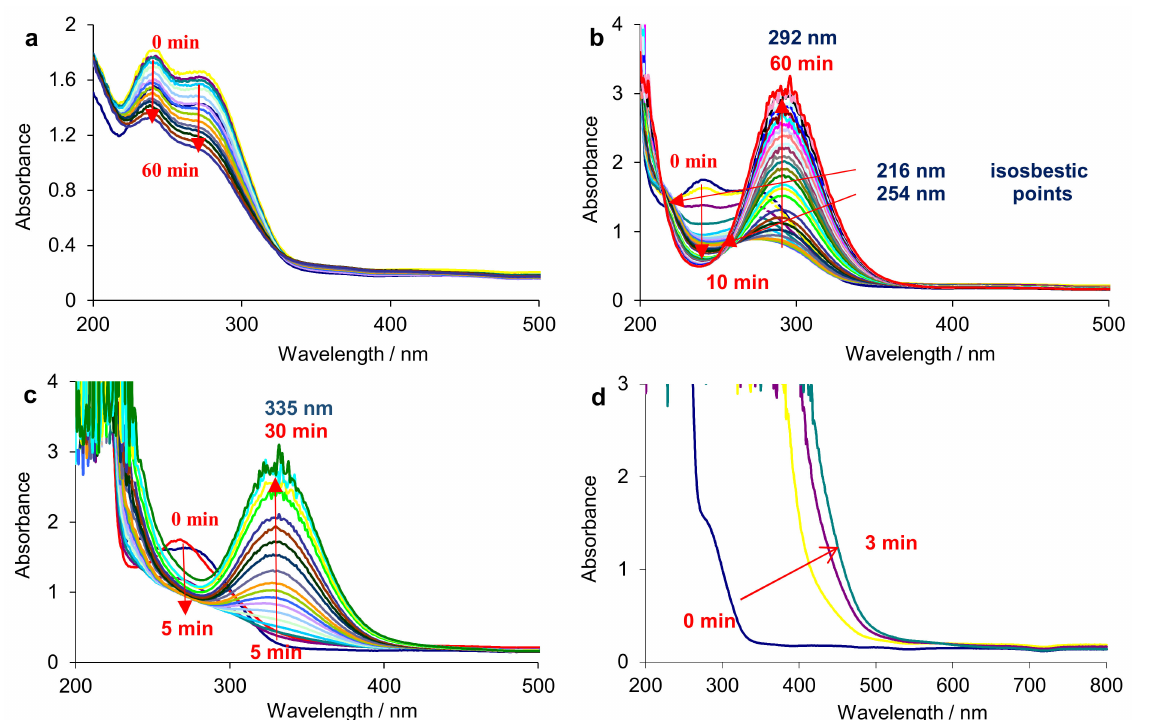
Figure 3. UV-Vis spectra of CFTX recorded on platinum electrode, in solutions of sodium halides during constant current electrolysis: ( a ) CFTX/NaF solution; ( b ) CFTX/NaCl solution; ( c ) CFTX/NaBr solution; ( d ) CFTX/NaI